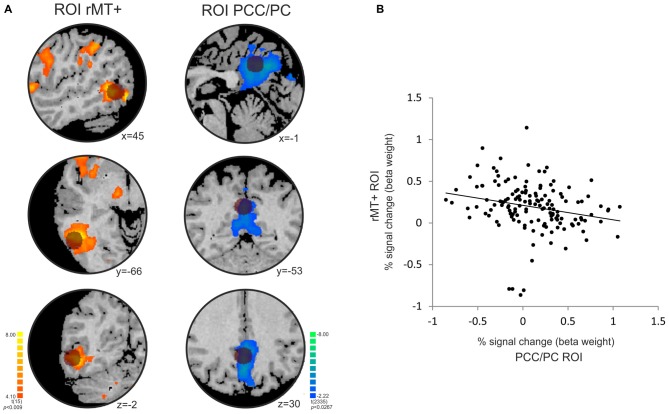
Temporal anticorrelation between PCC/PC and right middle temporal area (rMT+). (A) The location of the PCC/PC ROI (x y z = 0, −52, 30; Fransson, 2006) and rMT + ROI (x y z = 45, −69, −2; Fox et al., 2005) used in the analysis is depicted by the dark circles on top of the statistical maps for the contrasts [non-periodic > periodic] (orange-yellow scale) and [non-periodic < periodic] (blue-green scale). (B) Correlation plot between the percent signal change extracted from the rMT+ (y-axis) and PCC/PC (x-axis) ROIs averaged across subjects at each volume of acquisition (r = −0.228; p = 0.006).